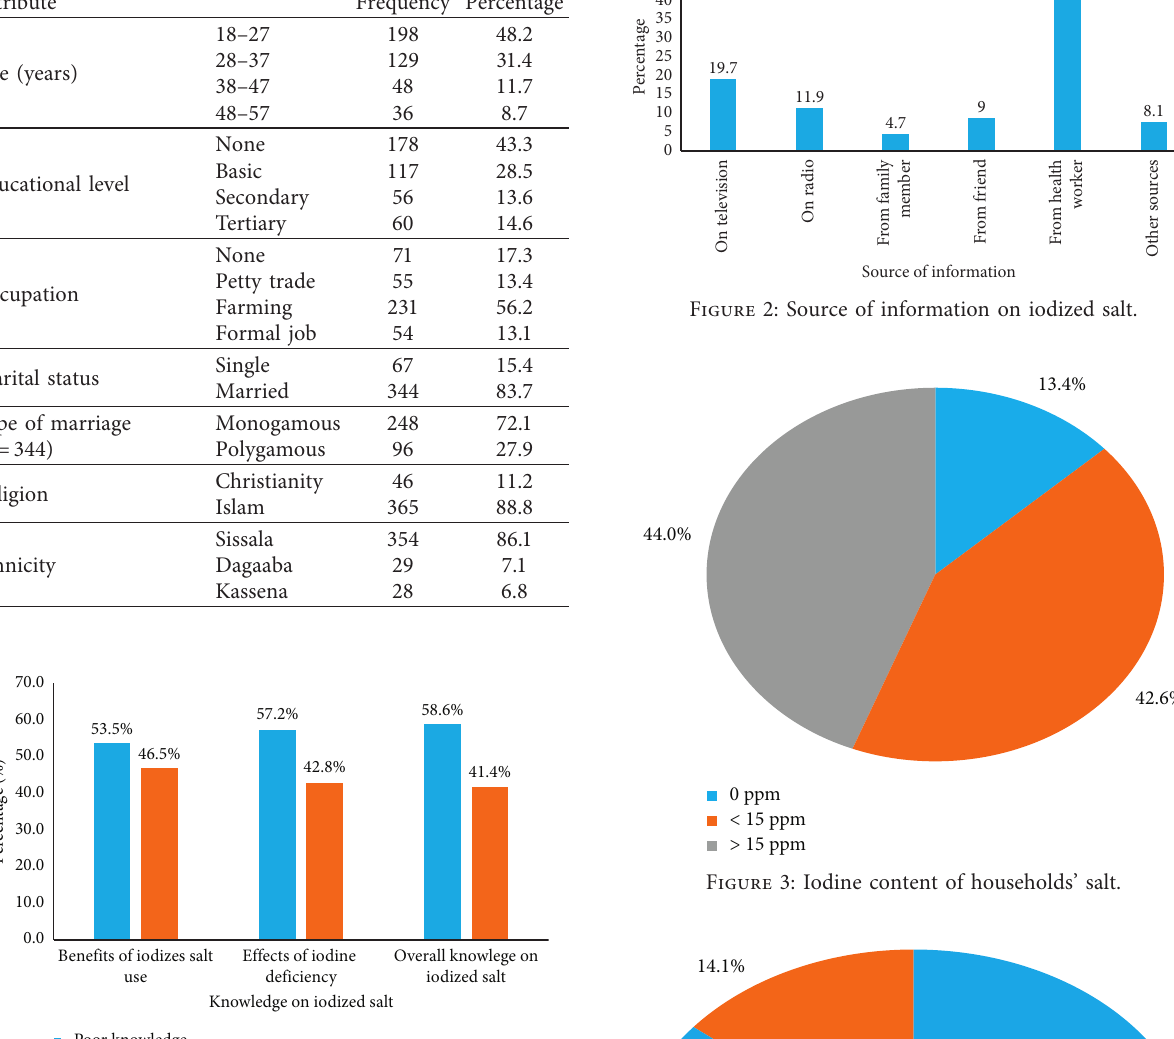
Table 1: General characteristics of participants. Attribute